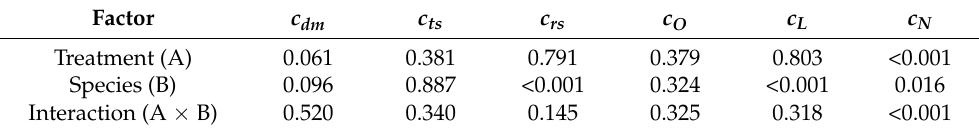
Figure 1. Effect of biostimulants on plant height, fresh herbage weight, and yield in the analyzed herb species: a–e—various letters denote significant differences at p < 0.05 (Tukey’s test); CA—application of Calleaf Aminovital; MAP—application of Maximus Amino Protect. Table 2. p -Value of ANOVA for the nutrient composition of herbage in the analyzed herb